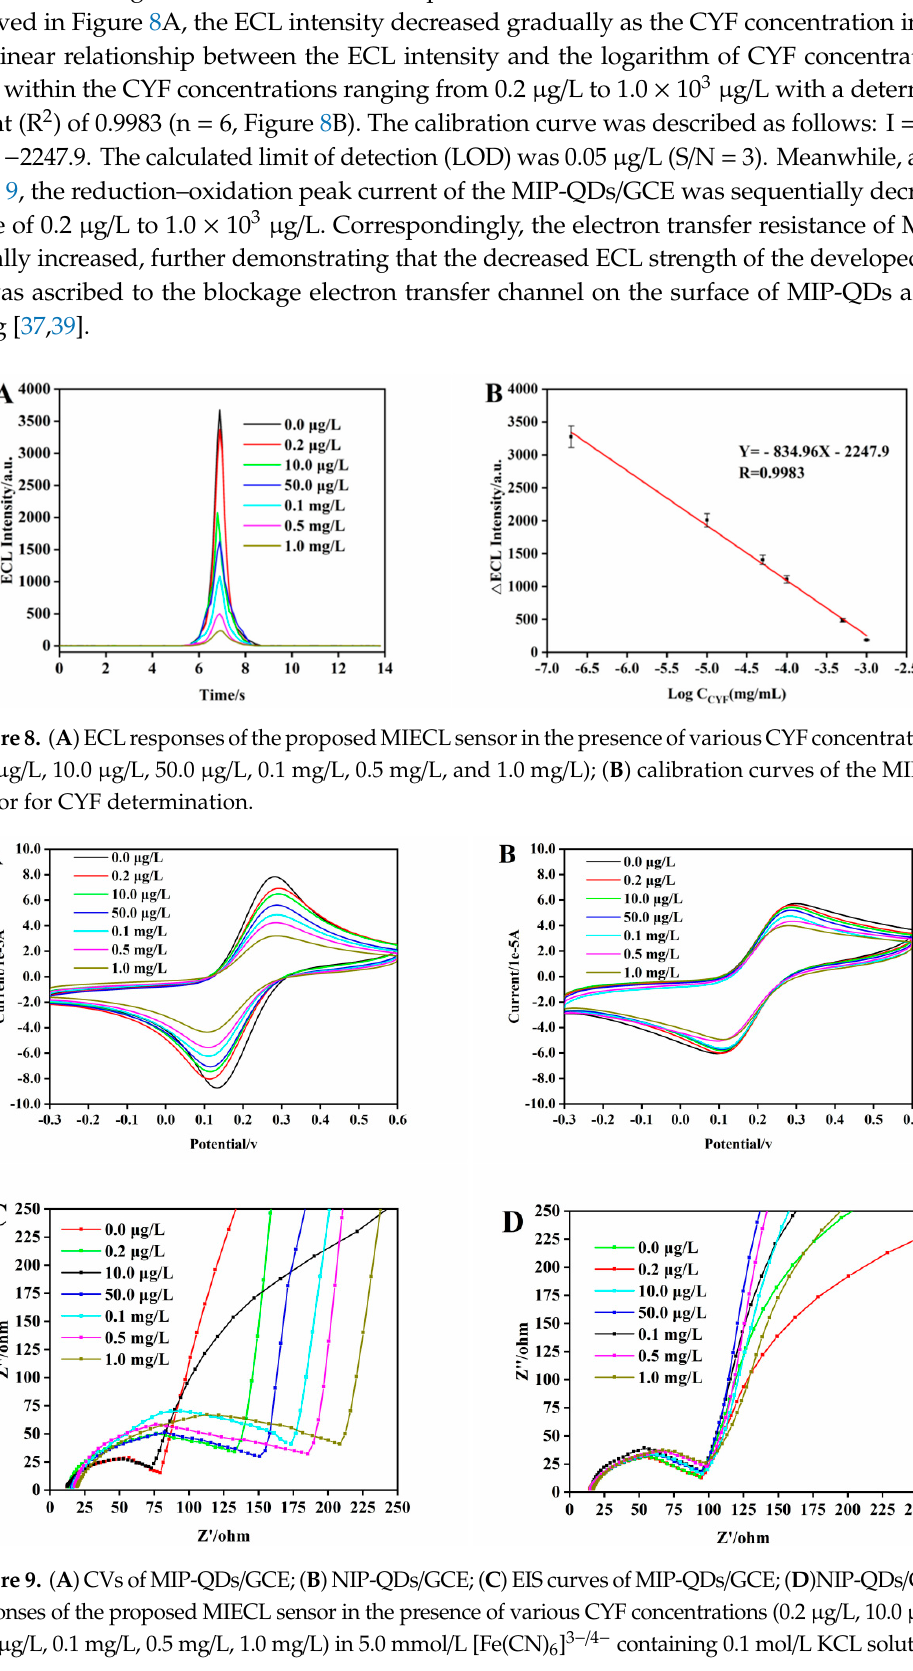
Figure 10. ( A ) ECL stability of the MIECL sensor with 10.0 µg/L CYF in PBS (100.0 mmol/L, pH 9.0) containing 20.0 mmol/L H 2 O 2 ; ( B ) Storing stability of the sensor for 0–4 weeks. The developed MIECL sensor was applied to the determination of different CYF concentrations in fish and seawater samples. As summarized in Table 1, the recoveries of CYF in fish samples at three spiked concentrations (10.0, 20.0, and 50.0 µg/kg) ranged from 93.2% to 98.6% with RSDs below 3.6%. The LOD, which was defined as the CYF concentration that could quench three times the standard deviation of the blank sample ECL signal, was 0.22 µg/kg. The recoveries obtained from